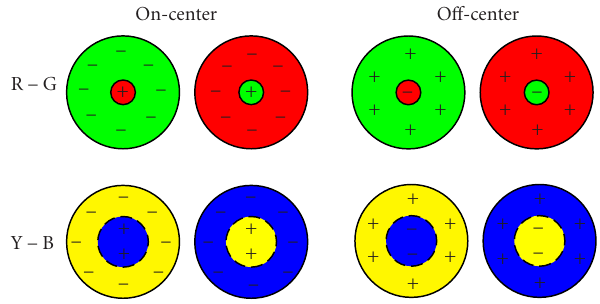
Figure 3: Color opponent receptive fields in the visual cortex. Unipolar o ff - and on-cells of G − B and Y − B are used to construct the HSI representation.